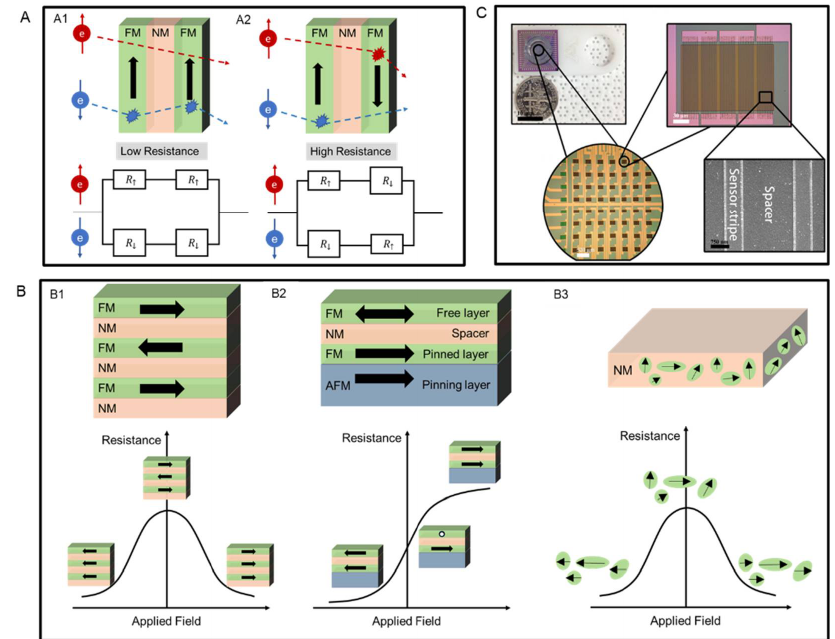
Figure 3. ( A ) Schematic diagram of the two-current model for spin channels in ( A1 ) par- allel magnetization states and ( A2 ) antiparallel magnetizations states, ( B ) Schematic views of ( B1 ) GMR multilayer structure, ( B2 ) spin-valve structure, and ( B3 ) granular structure, and their corresponding change of resistance in response to applied field curves. ( C ) A typical GMR chip consists of an 8 × 8 sensor assay. ( C ) is reprinted with permission from Ref. [89], under the terms of the Creative Commons Attribution License (CC